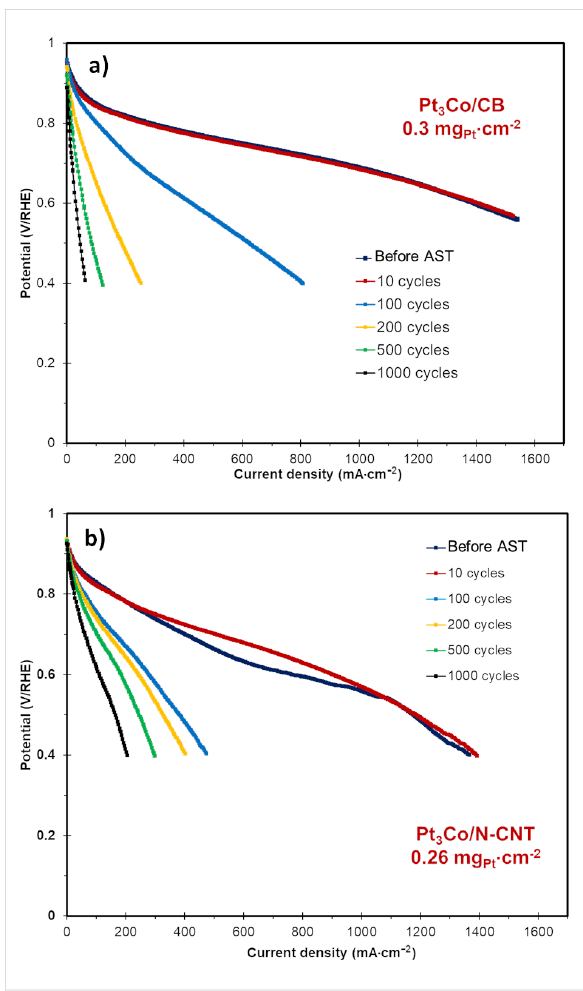
Figure 13: Polarization curves performed on MEAs integrating: a) Pt 3 Co/CB; and b) Pt 3 Co/N-CNT. Dark blue: after conditioning, red: after 10 cycles, light blue: after 100 cycles, yellow: after 200 cycles, green: after 500 cycles and black: after 1000 cycles.